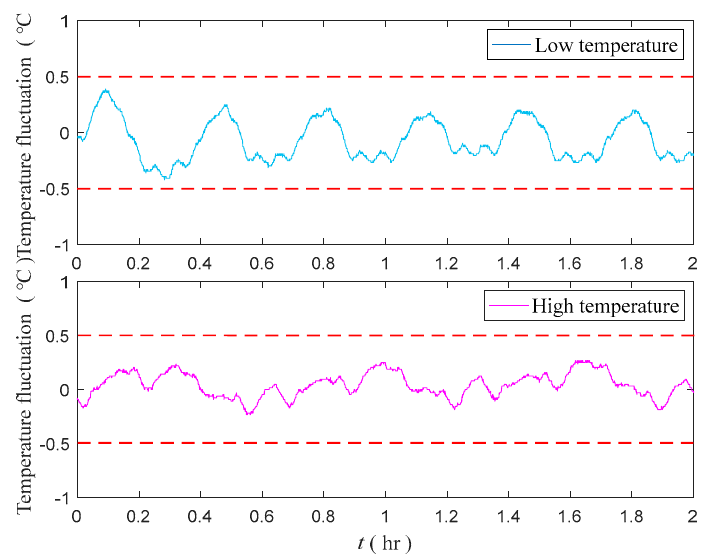
Figure 14. Temperature fluctuation of temperature control system after optimization in high and low temperatures.